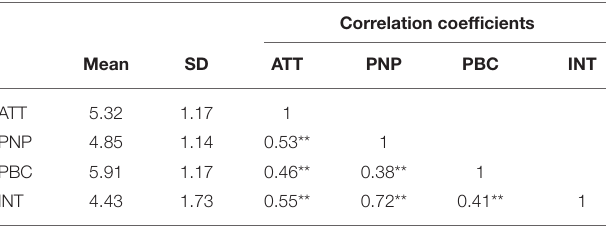
TABLE 1 | Means, standard deviations, and correlation coefficients for the theory of planned behavior components ( N = 138). Correlation